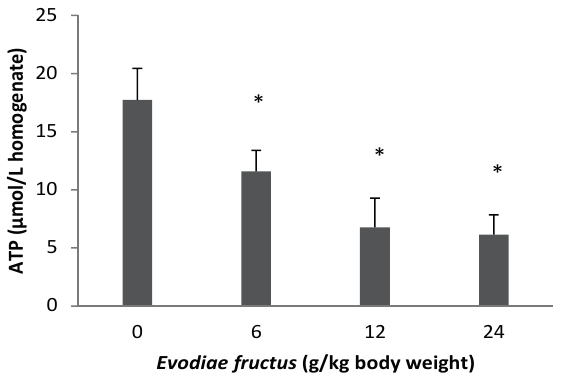
Figure 7. Effects of aqueous extract of EF on liver tissue ATP. Data were presented as mean ± SEM (n = 10). Compared with control group * p < 0.05.